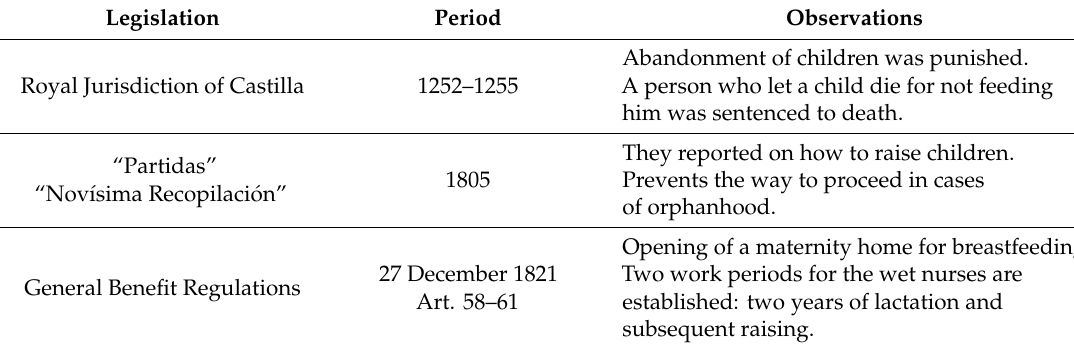
Table 1. Wet nurse industry